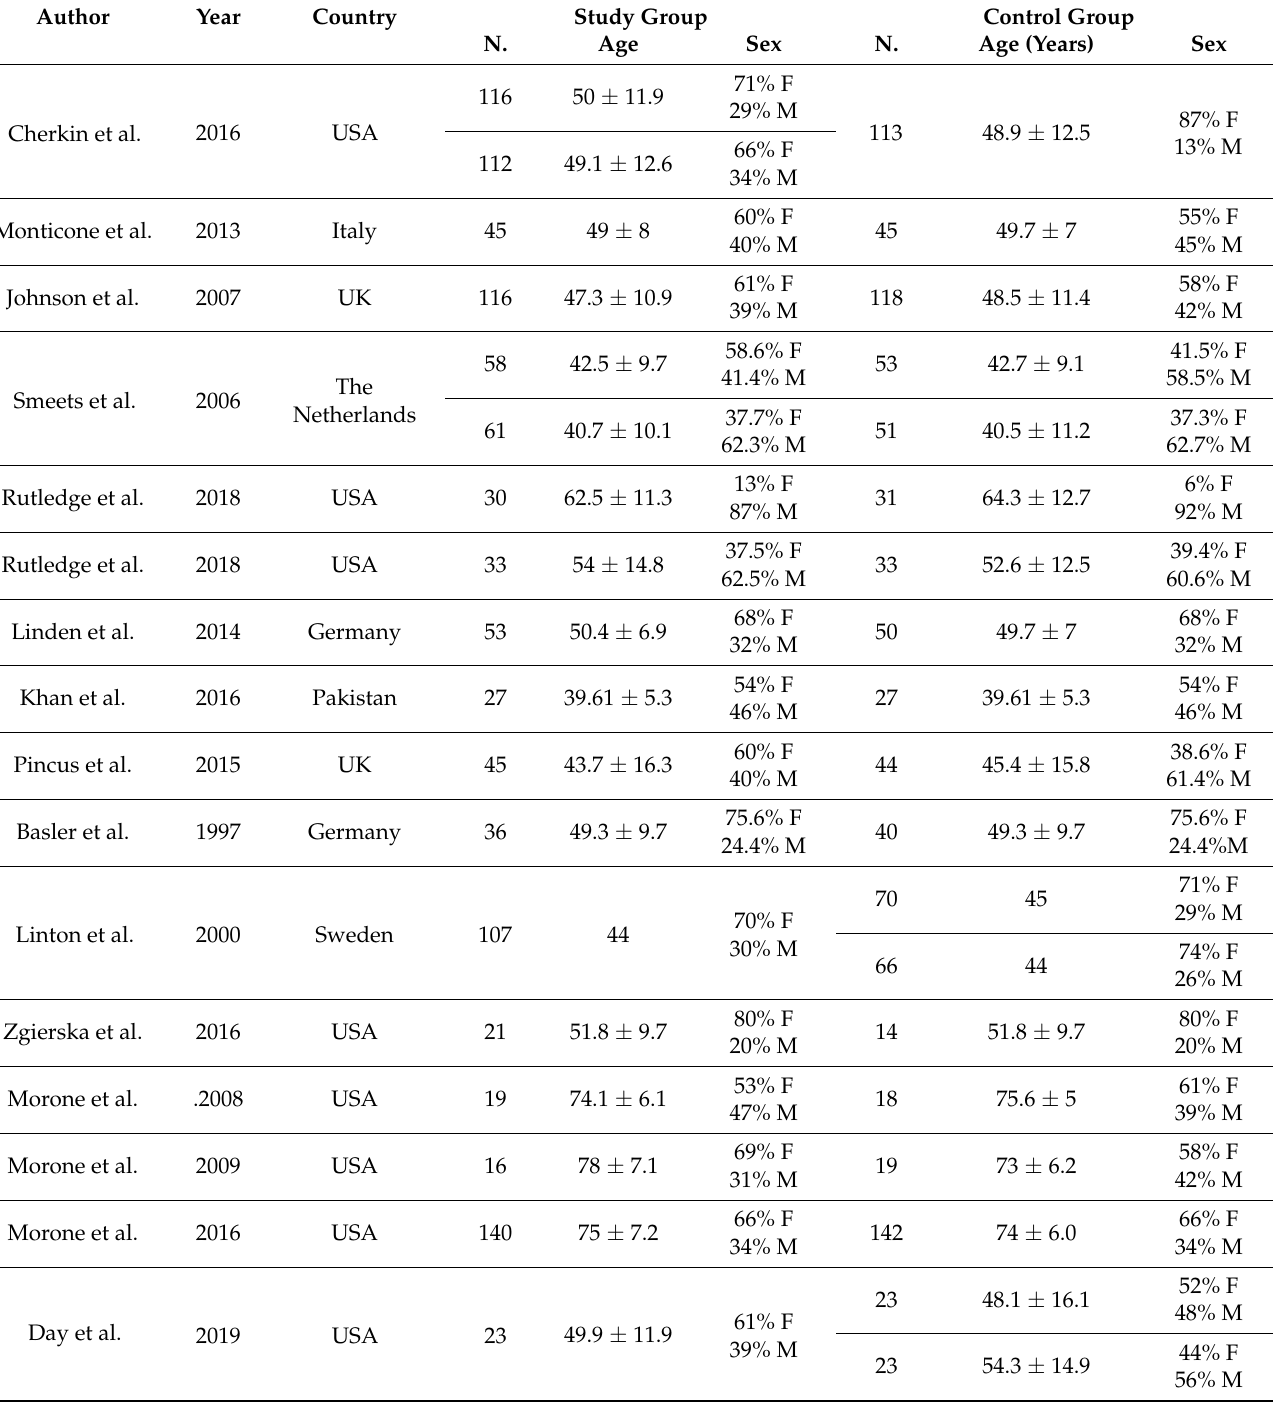
Table 1. Main characteristics of the included studies and